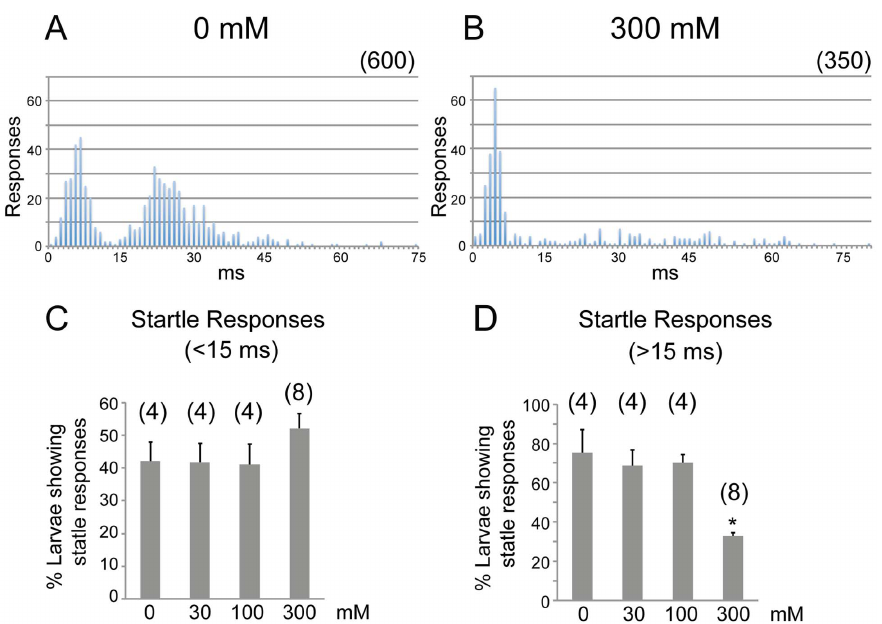
Figure 5. The effects of ethanol on acoustic startle responses. Histograms showing the latency distribution of startle responses of free- swimming larvae after 1 hr exposure to 0 (A) and 300 mM ethanol (B). N in parenthesis is the number of responses analyzed (from a total of 100–120 larvae each). Percentage of larvae showing responses with latencies , 15 ms (C) and . 15 ms (D) after exposure to 0, 30, 100 and 300 mM ethanol. (* P , 0.001 t-test compared to 0 mM group). N=4 groups of 20 larvae (0, 30, 100 mM treatments) or 8 groups of 20 larvae (300 mM